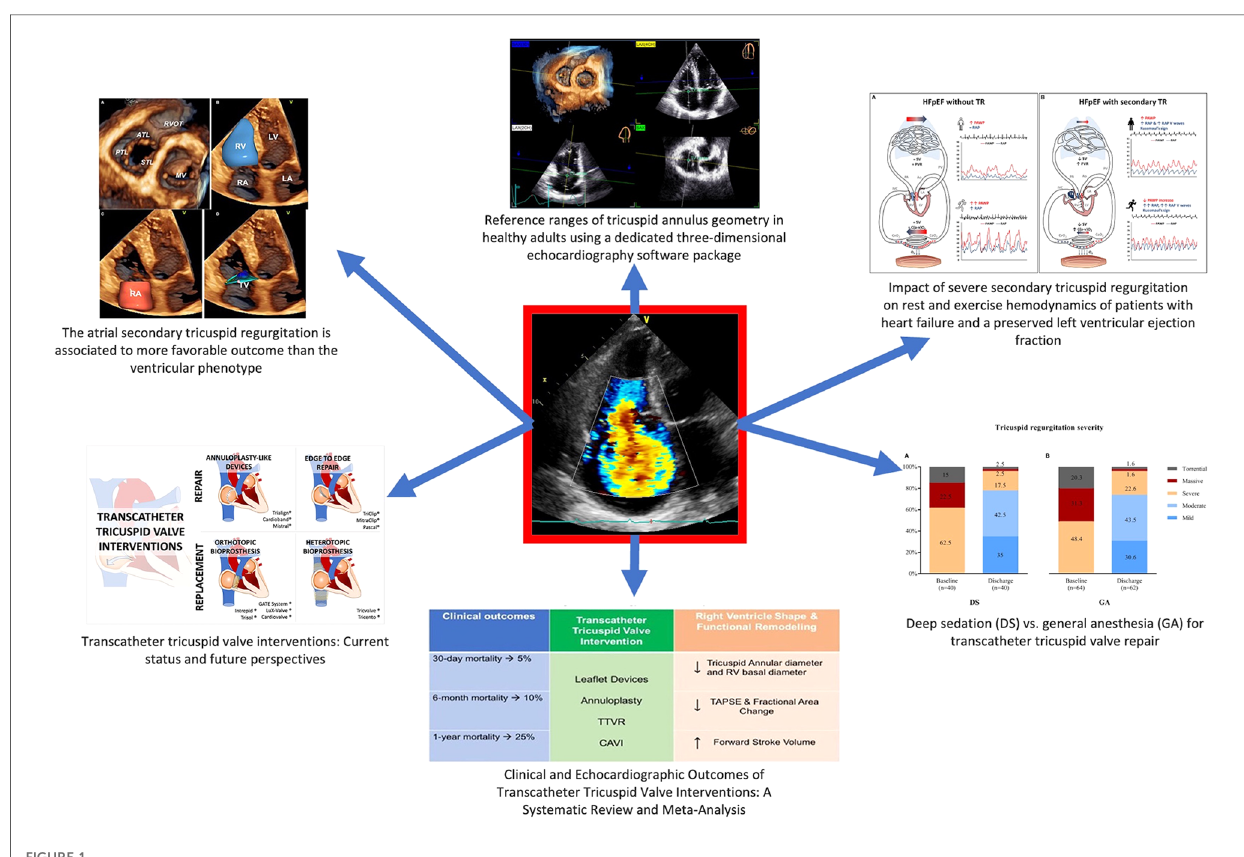
FIGURE 1 Open issues in the diagnosis and management of tricuspid